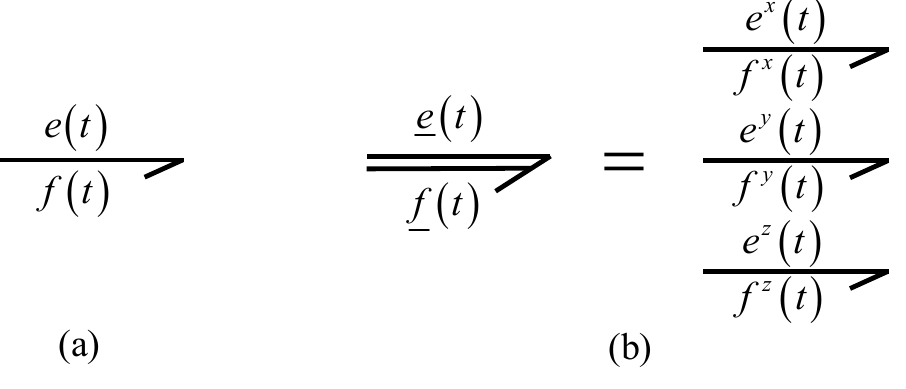
Figure 5. Bonds; ( a ) single bond; ( b )